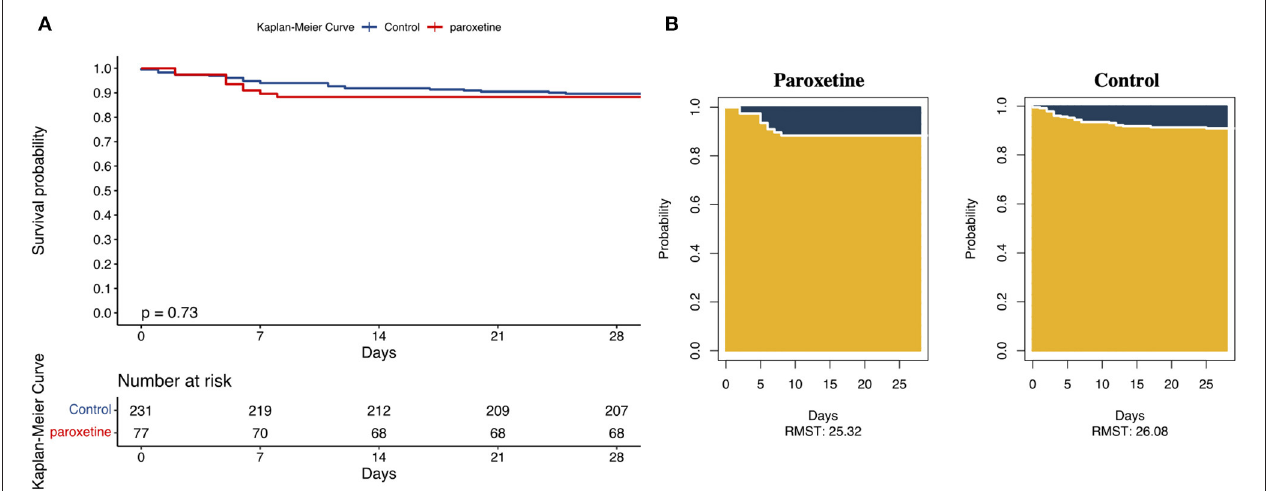
FIGURE 2 | (A) Kaplan–Meier Curves and Restricted Mean Survival Time (RMST) for the Incidence of 28-Day All-Cause Death. This was a 1:3 matched cohort. The follow-up time was 28 days in both the groups. (B) The RMST for the primary endpoint (all-cause death) was 25 days (95% CI, 24–27 days) in the paroxetine group and 26 days (95% CI, 25–27 days) in the control group. There were 24 patients in the paroxetine group with an event and nine in the control group.